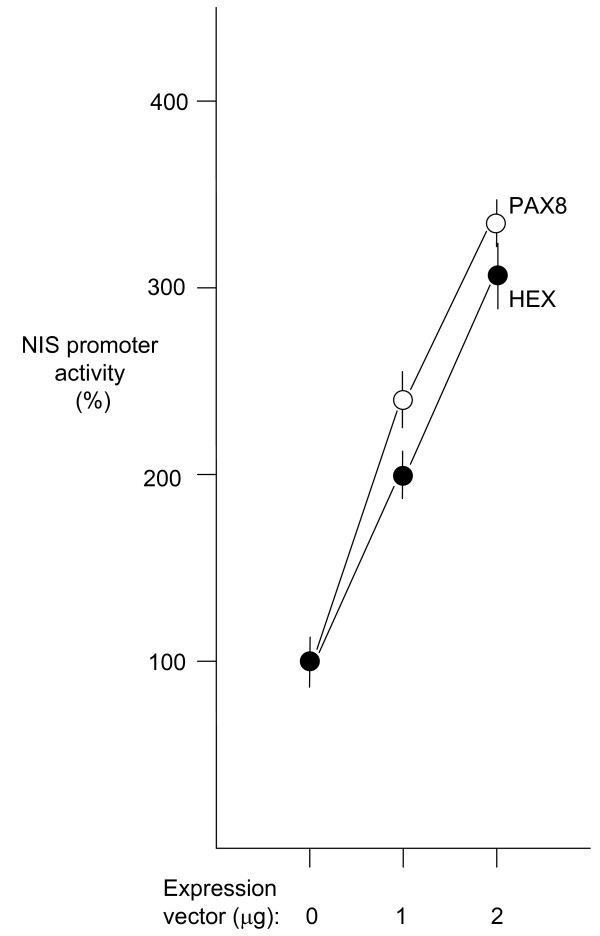
HEX effects on NIS promoter. HeLa cells were transfected with 1 and 2 μg of the HEX or PAX8 expression vector together with plasmids containing the NIS and the CMV promoters linked to the LUC and the βGAL reporter genes, respectively. The CMV-βGAL plasmid was used to normalize for efficiency of transfection. Each dot represents the mean value ± standard deviation of four independent transfections. Results are expressed as percentage of the values obtained in cells not transfected with HEX or PAX8 expression vectors.